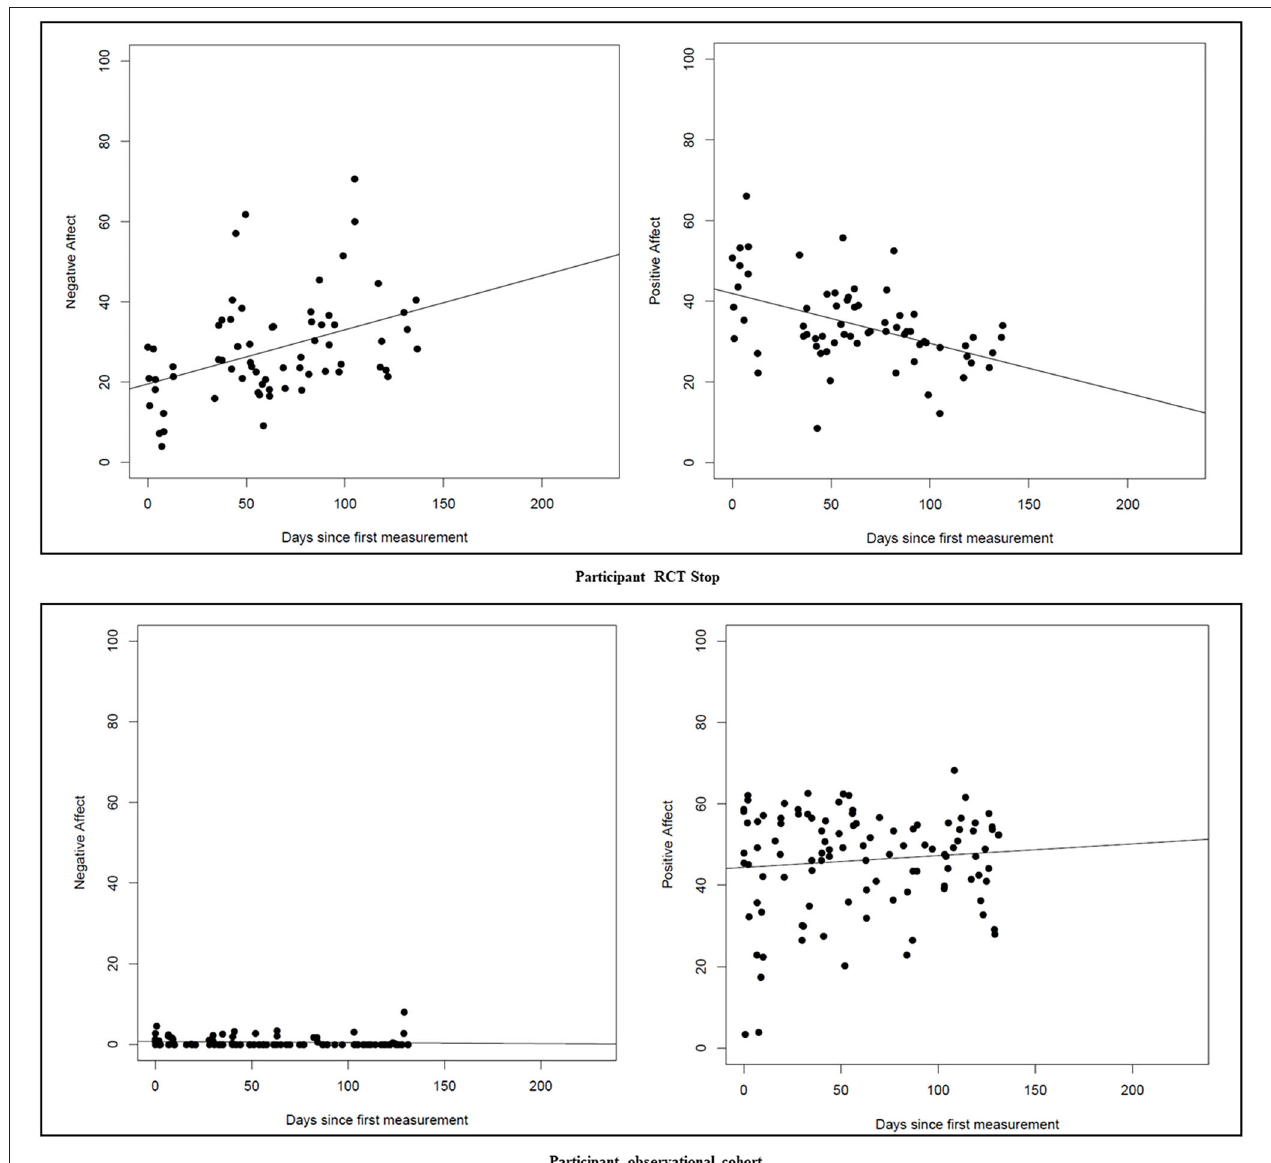
FIGURE 2 | Two participant examples of positive and negative affect fluctuations in the